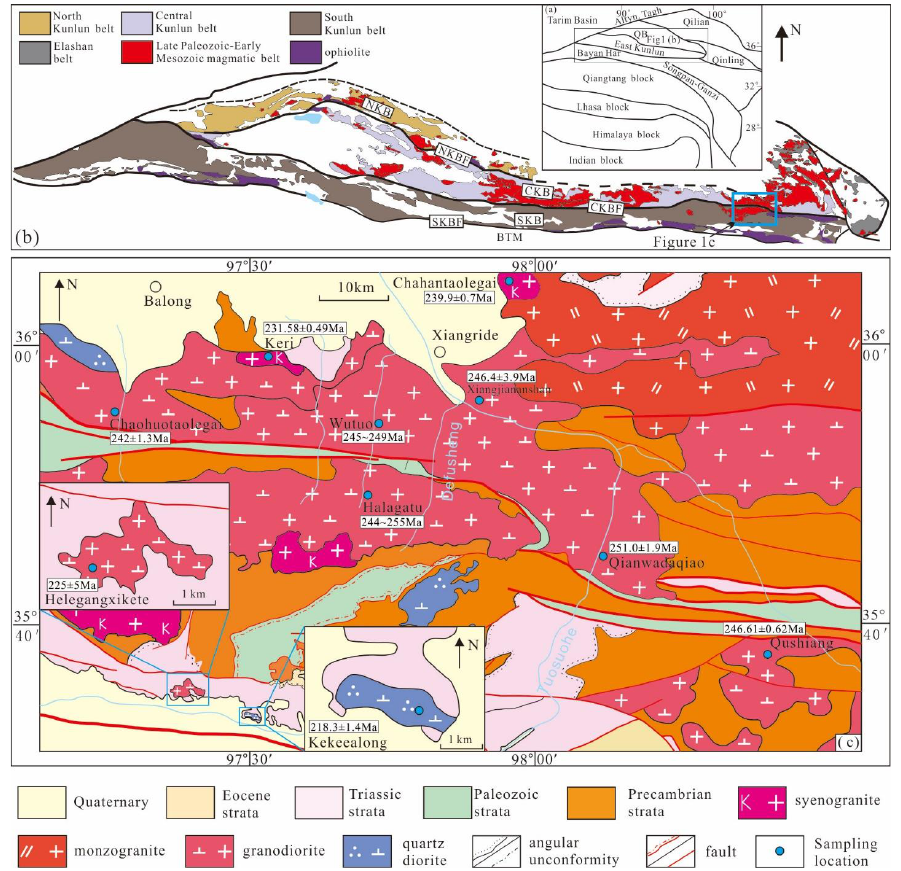
Figure 1. ( a ) Tectonic location of the East Kunlun Orogen in China; ( b ) Distribution of granites of late Paleozoic to early Mesozoic in the Eastern Kunlun; ( c ) Simplified geological map for the eastern part of the EKO (modified from Li et al. [19]). Data sources for the zircon U – Pb ages are as follows: Halagatu pluton (after [19]); Xiangjiananshan pluton (after [20]); Wutuo pluton (after [20,21]); Qushiang pluton (after [22]); Chaohuolutaogai pluton (after [23]); Chahantaolegai pluton (after [24]); Keri pluton (after [25]); Kekeealong pluton (after [26]); Helegangxilikete pluton (after [27,28]).